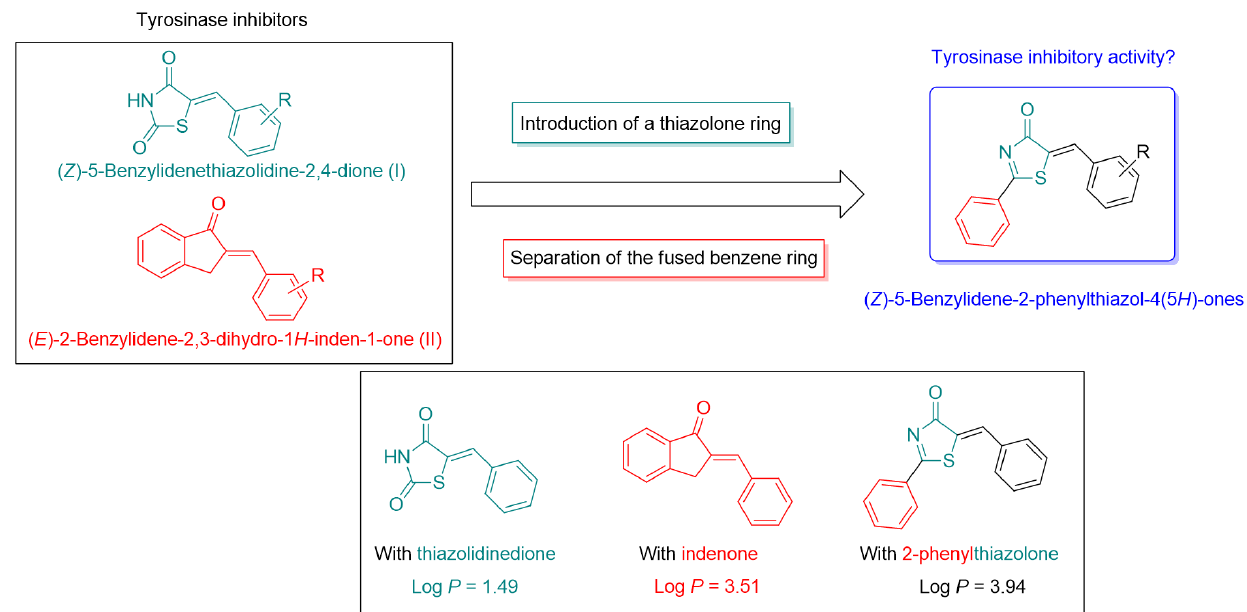
Figure 1. Rationale for synthesizing ( Z )-5-benzylidene-2-phenylthiazol-4(5 H )-ones and the log P values of benzylidene compounds on thiazolidinedione, indenone, and 2-phenylthiazolone scaffolds.